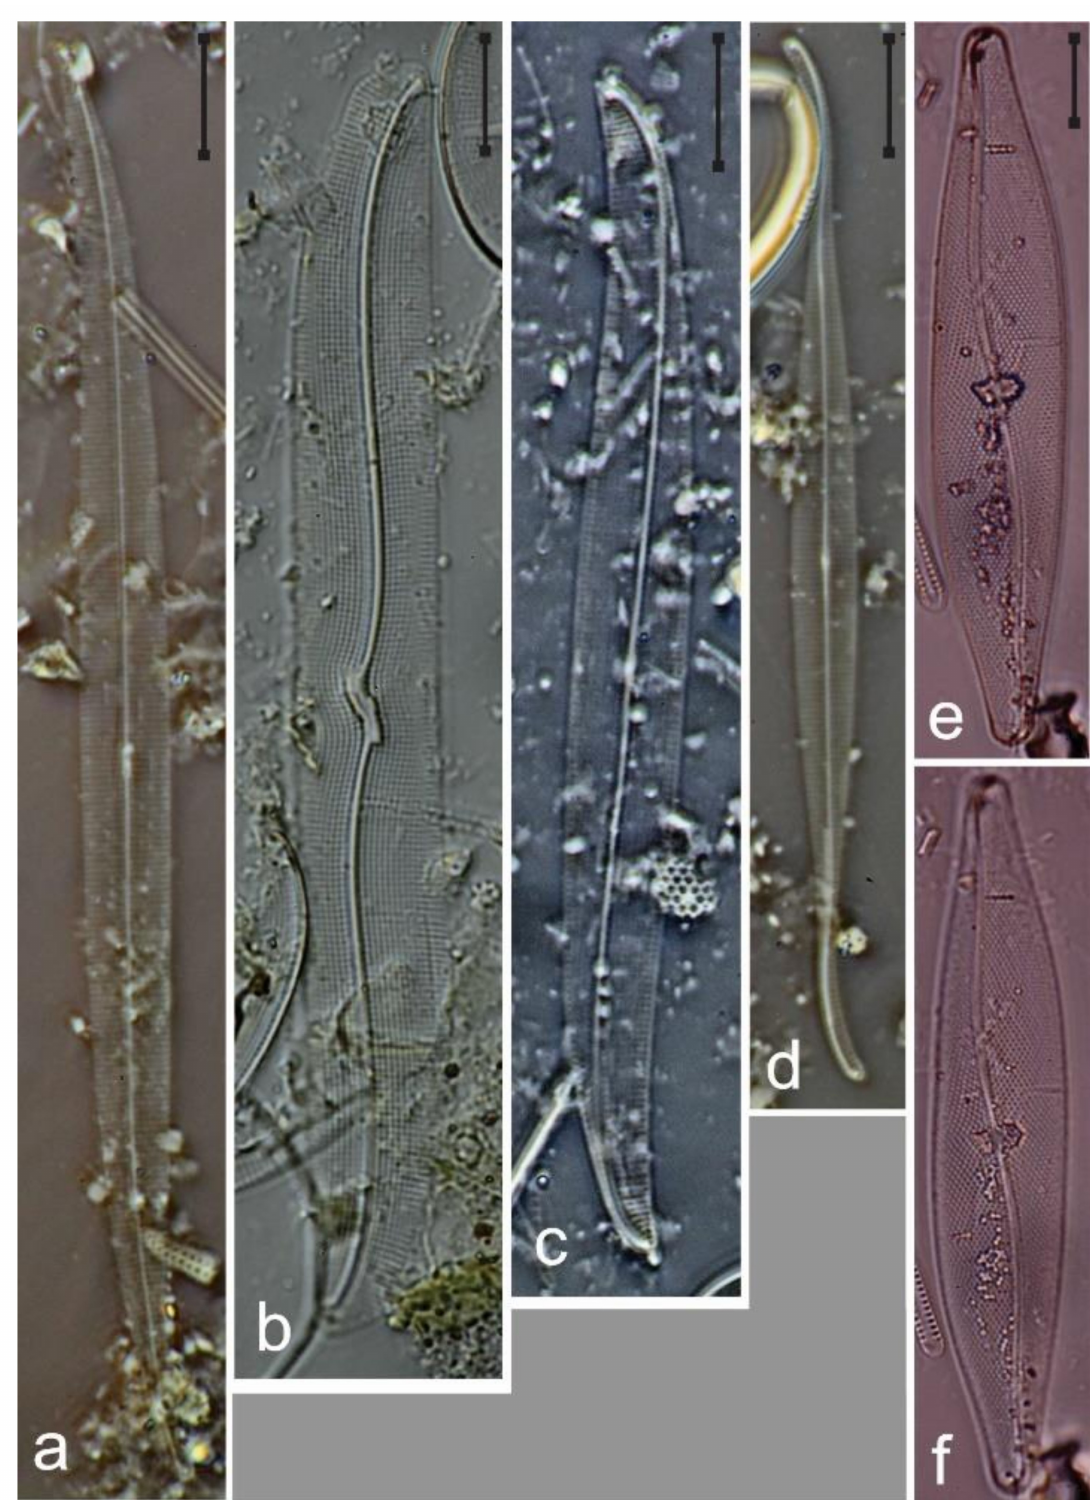
Figure 40. ( a ) Gyrosigma tenuissimum var. hyperboreum ; ( b ) G. balticum ; ( c ) G. peisonis ; ( d ) G. reversum ; ( e , f ) Pleurosigma naviculaceum . Scale bar = 10 µ